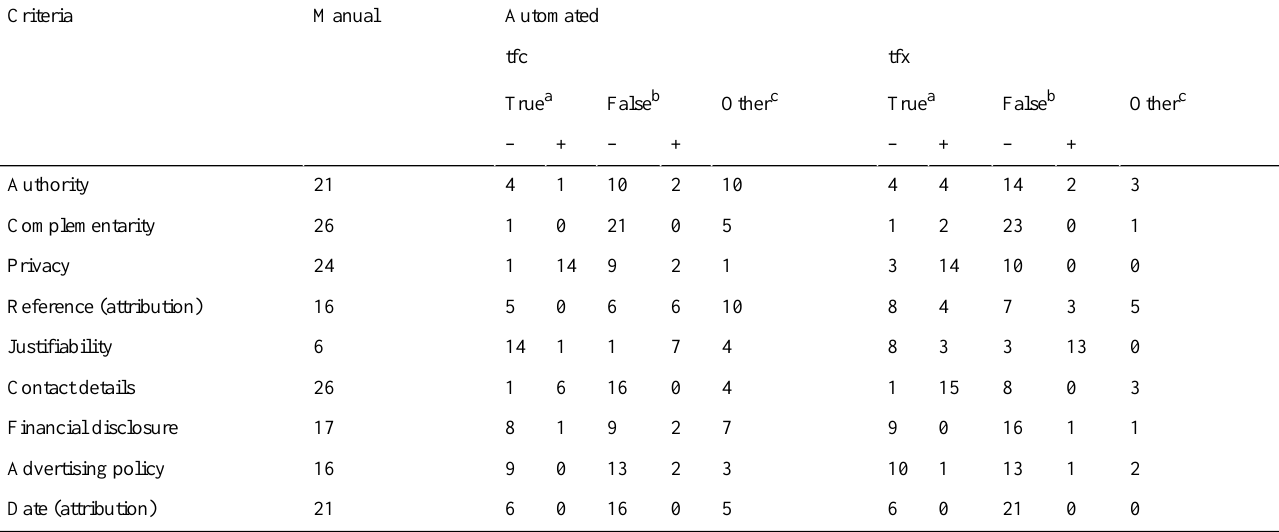
Table 1. Manual versus automated (using tfc and tfx weightings) evaluation (N=27).